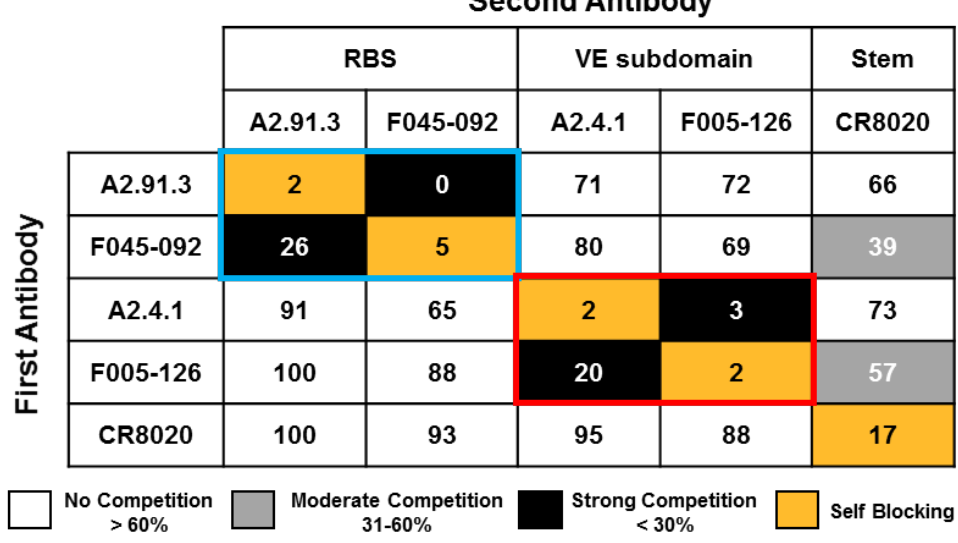
Figure 2. Epitope mapping of A2.91.3 and A2.4.1 by competition with a panel of HA site-specific monoclonal antibodies. Competition binding assays were performed by Octet QK384 Bio-layer interferometry (BLI) with A/Hong Kong/4801/2014 HA nanoparticles amine coupled to biosensor tips. Antibodies were bound sequentially, and binding normalized to buffer control without competition (100%). A2.91.3 had strong competition with receptor binding site (RBS) antibody F045-092 (blue box). A2.4.1 had strong competition with vestigial esterase (VE) subdomain antibody F005-126 (red box). Minimal competition was detected with stem antibody CR8020. Strong competition was defined as < 30% max signal, moderate competition was between 31% and 60%, and no competition was > 60% max signal.